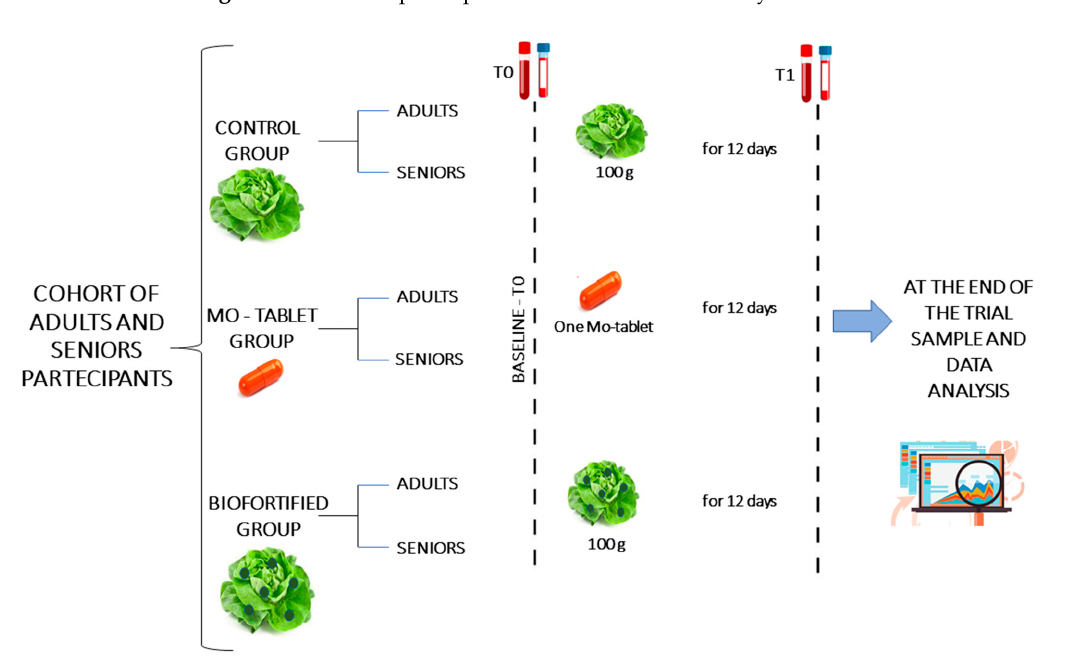
Figure 1. Process of participants’ recruitment in the study.